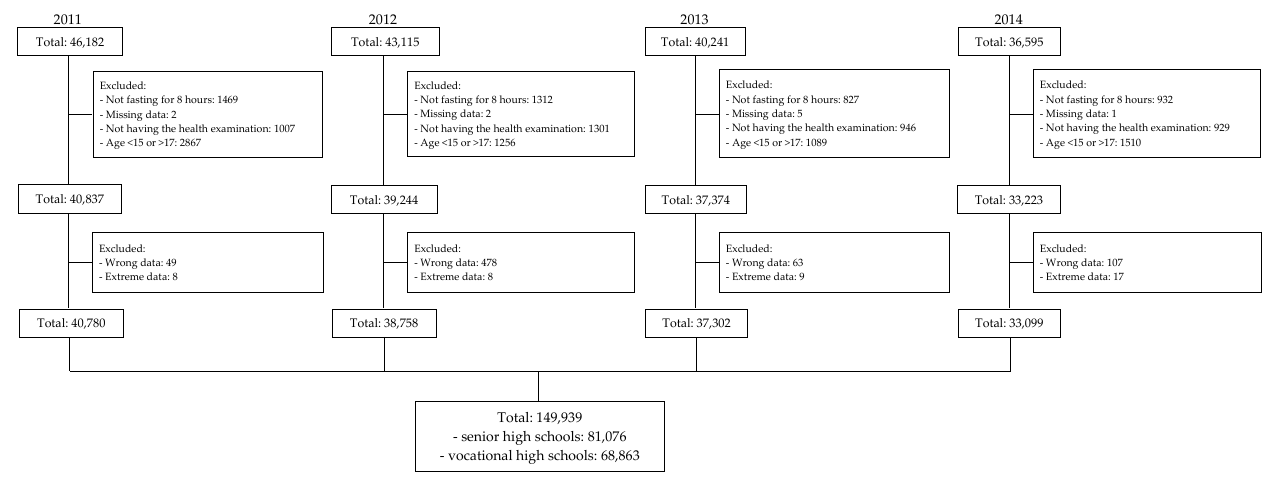
Figure 1. Flowchart of participant selection.